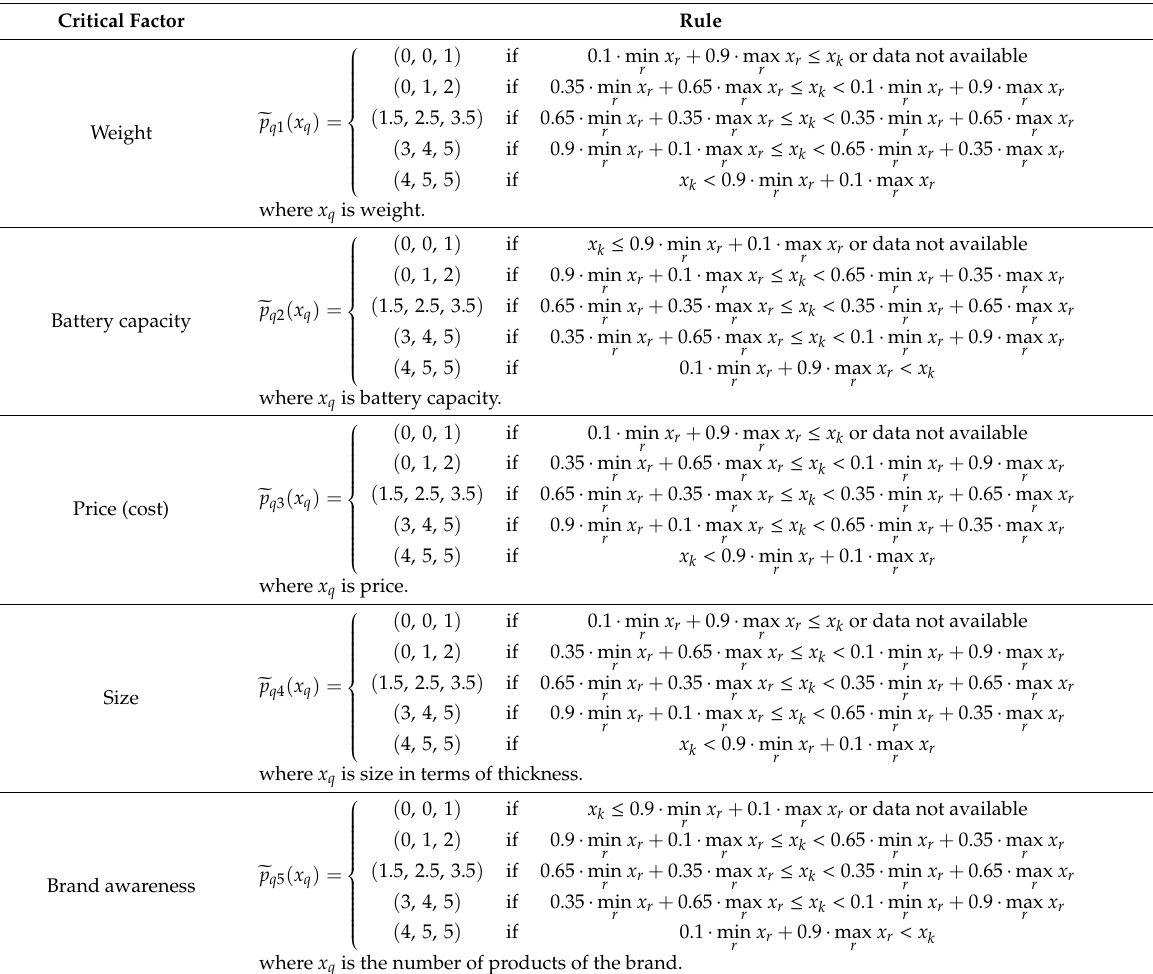
Table 2. Rules for evaluating the performances in optimizing critical